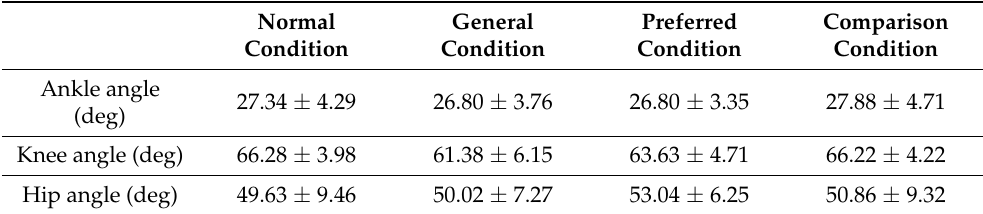
Table 2. The range of ankle, knee and hip angles under different walking conditions (mean and standard deviation).